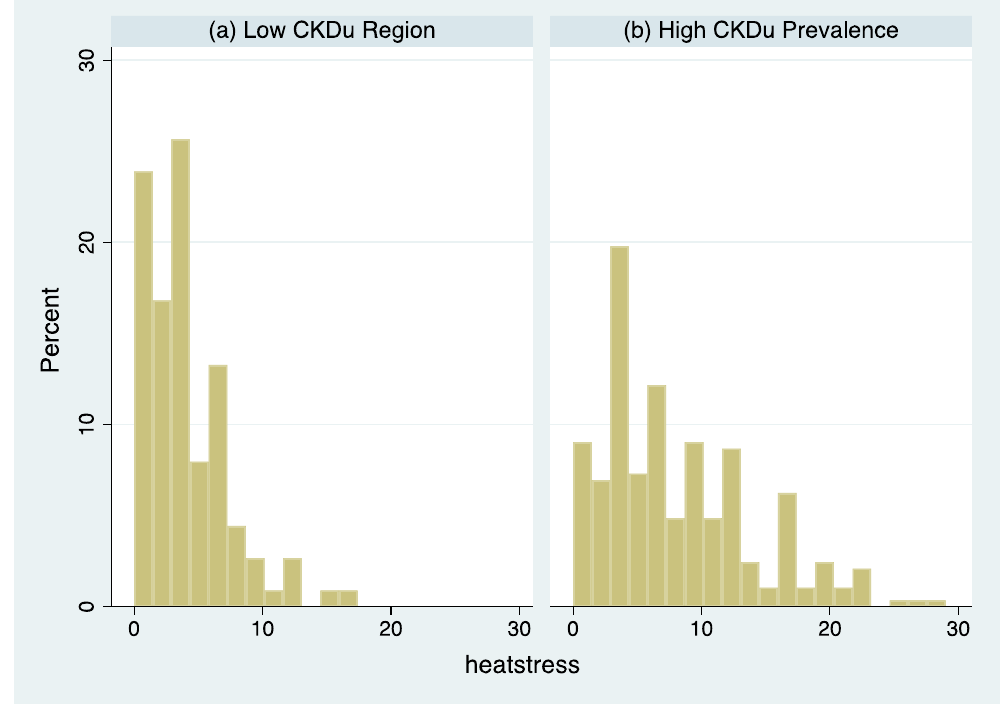
Figure 2. Histogram of the heat stress symptom index among agricultural workers: ( a ) Low CKDu Region, ( b ) High CKDu Region.